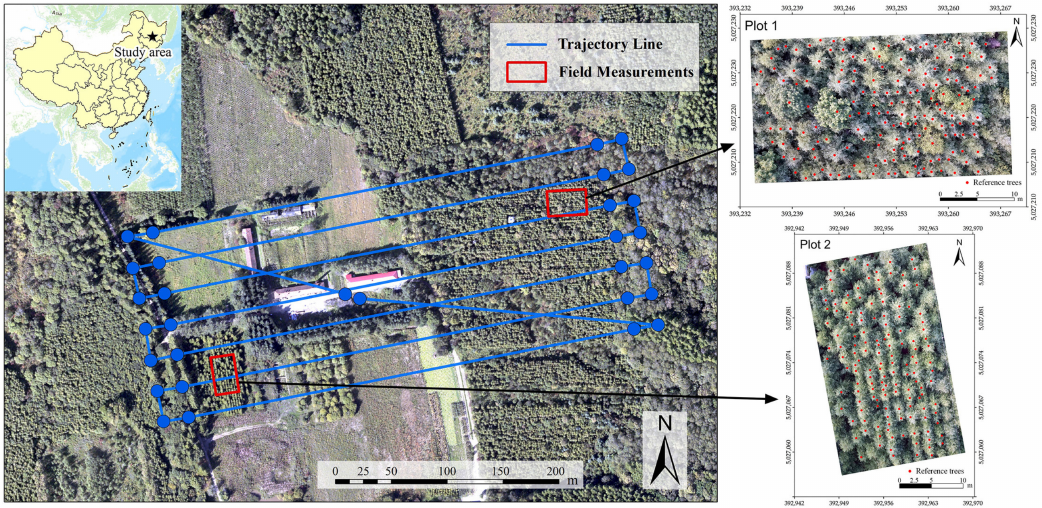
Figure 1. Location of the study area and schematic diagram of the unmanned aerial vehicle (UAV) route and reference data